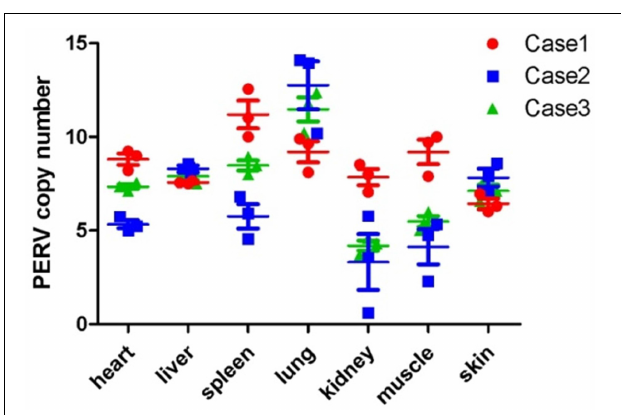
FIGURE 3 | The copy number of PERV in the different organs from the GZ breed is based on the ddPCR method. Each point indicates one test. The median and the standard deviations are shown. Three GZ breed cases were